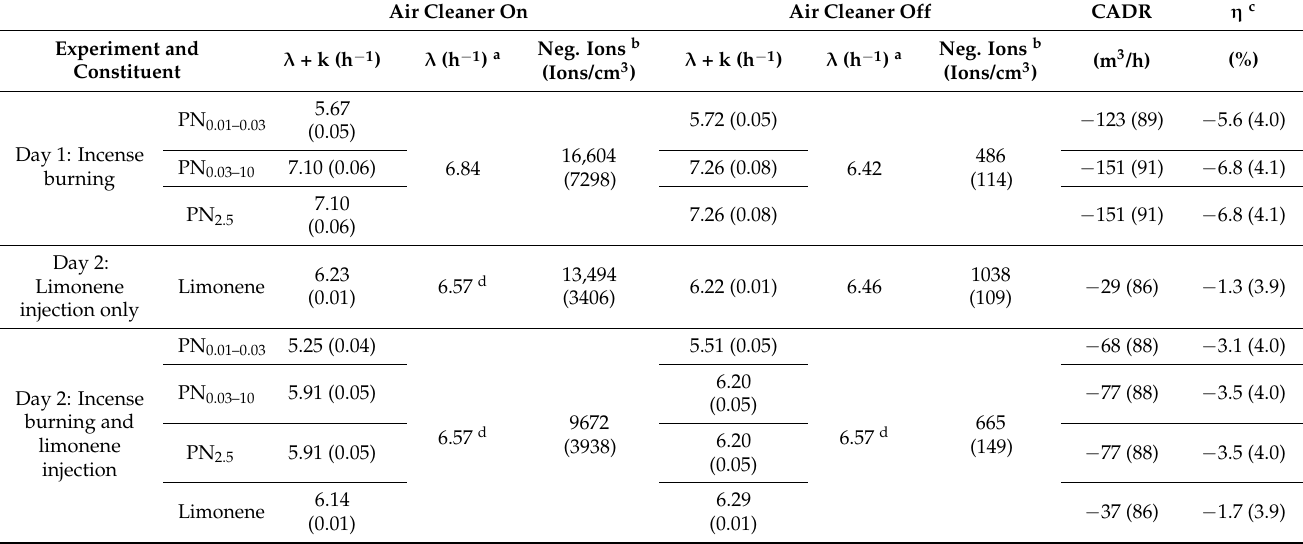
Table 5. Summary of experimental results from controlled laboratory studies at Portland State